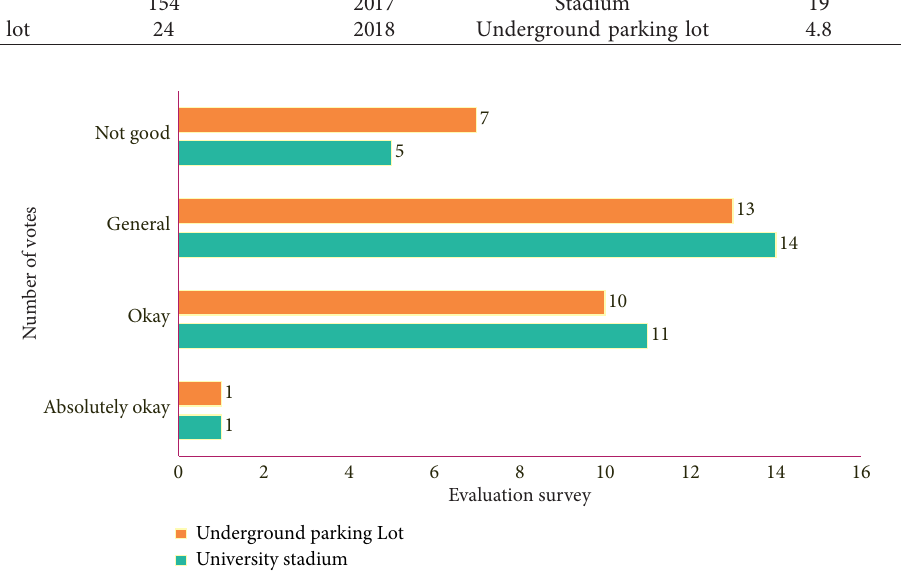
Figure 3: Research on subjective feelings of light guide tube lighting application